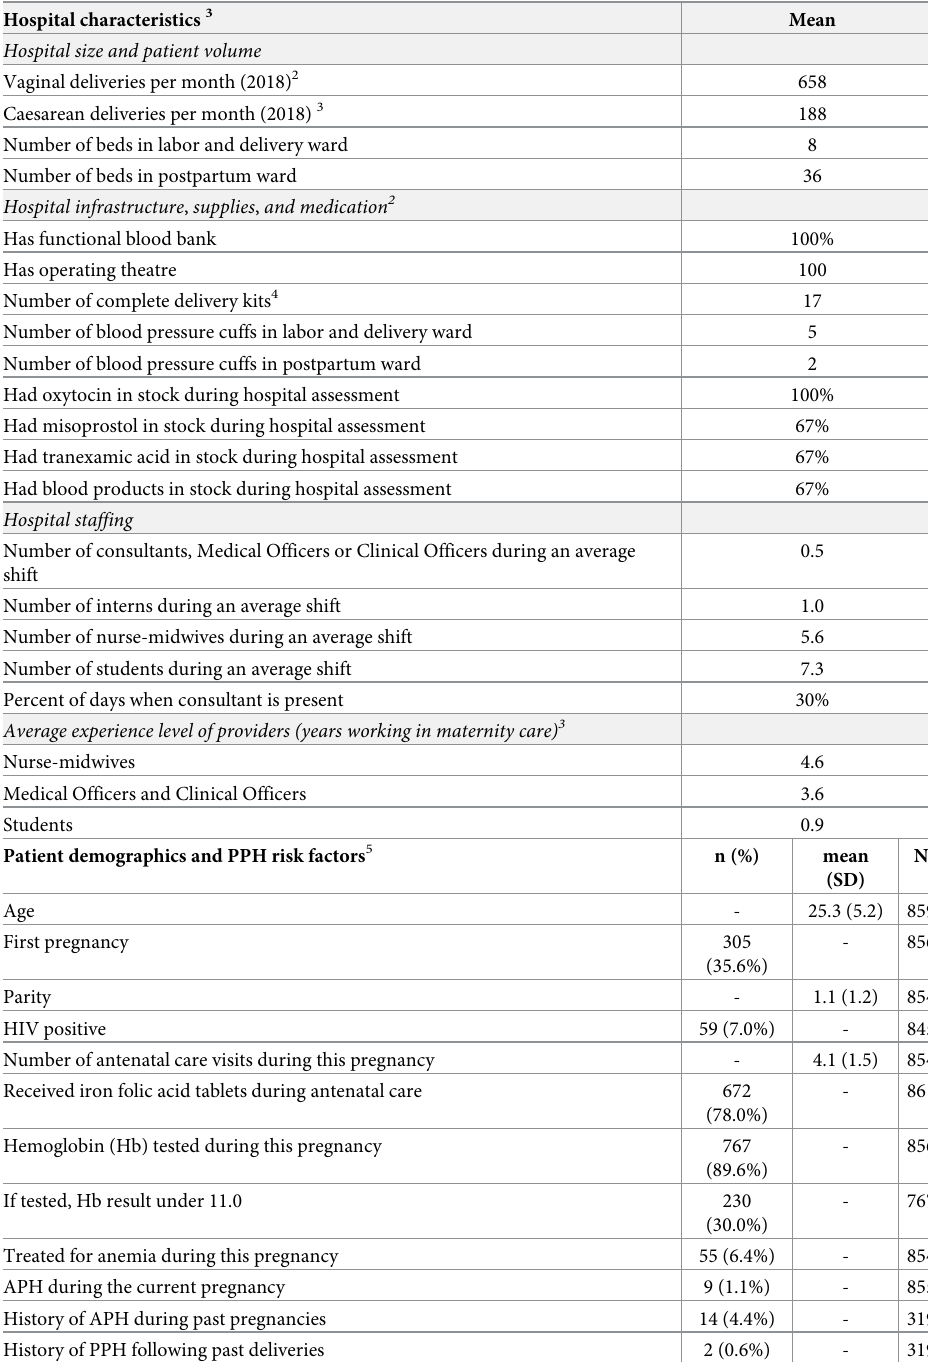
Table 1. Hospital and patient